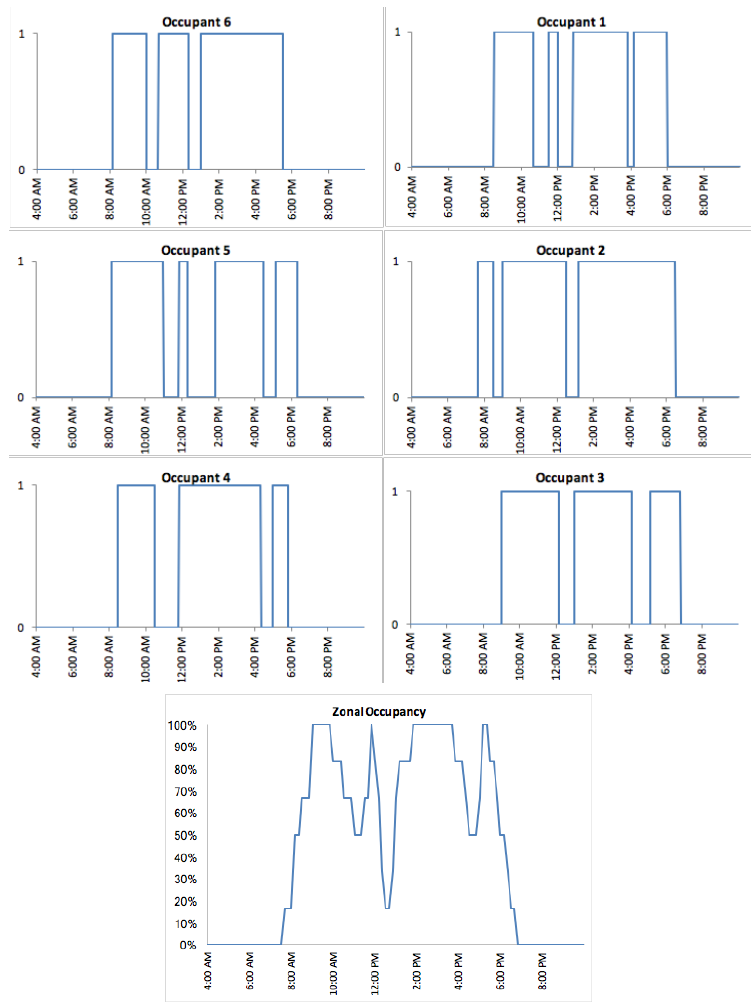
Figure 3. Daily occupancy patterns for each workstation, and summed occupancy fraction for the entire zone (bottom). Patterns of occupancy (1) and vacancy (0) frequency and duration for each workstation show daily routines that sum to a zonal occupancy pattern of build-up in the morning, a lunch dip, and gradual zone vacancy at the end of the